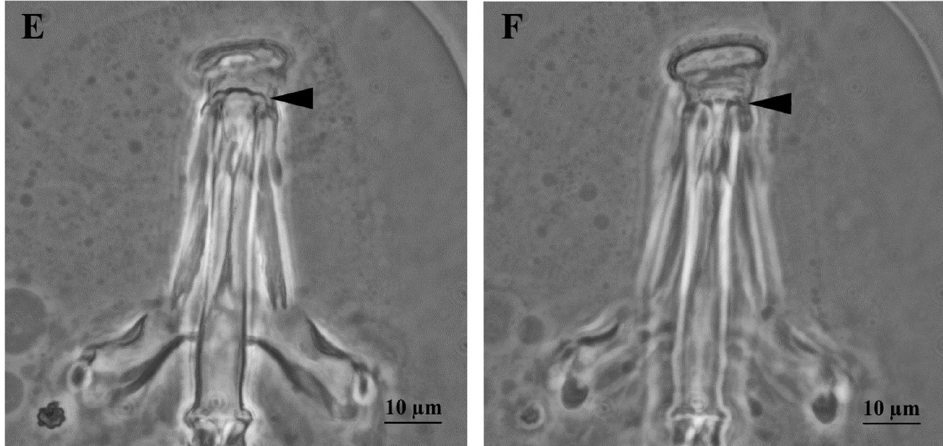
Figure 1. Macrobiotus kyoukenus sp. nov. ( A ) In toto and in vivo female specimen, asterisk denotes an egg; ( B ) Cuticular pores (arrowheads) after orcein staining; ( C ) Claws of the second pair of legs with lunules (arrowhead); ( D ) Buccal pharyngeal apparatus with two macroplacoids and one microplacoid (arrowhead); ( E ) Dorsal transversal crests of the buccal armature (arrowhead); ( F ) Ventral transversal crests of the buccal armature (arrowhead). ( A – C , E , F ) PhC; ( D ) DIC.